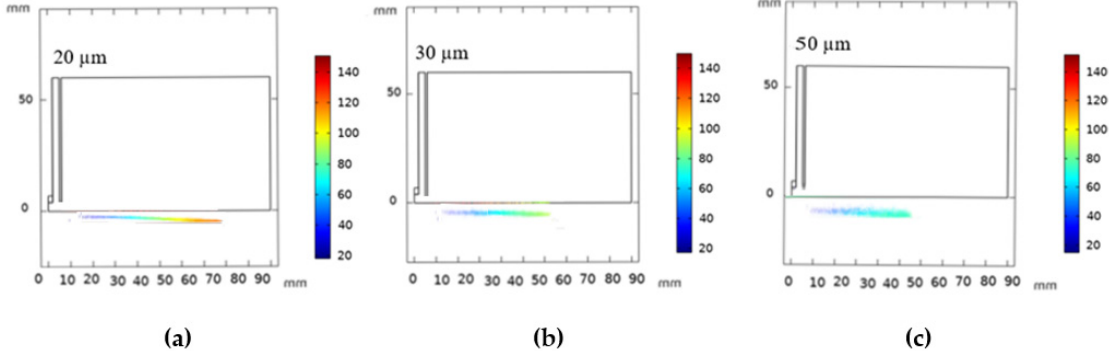
Nanomaterials 2022 , 12 , 1763 14 of 20